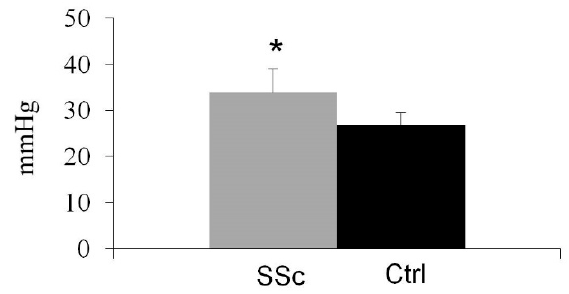
Figure 2. sPAP measurements in SSc and control groups. * p = 0.013. Table 3. Association between 25(OH)D 3 insufficiency and clinical parameters in systemic sclerosis.